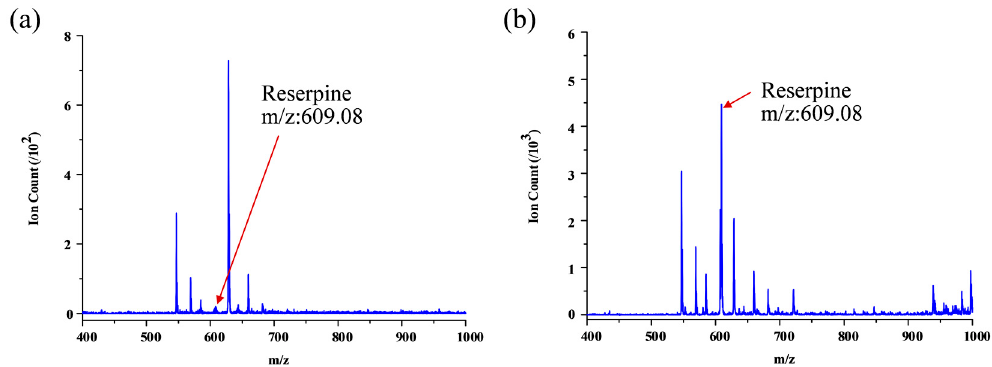
Figure 6. Results of SPME using urine sample spiked with 0.82 µM reserpine: ( a ) Direct ESI using a commercial capillary and ( b ) On-chip SPME and ESI using optimal chip configuration.